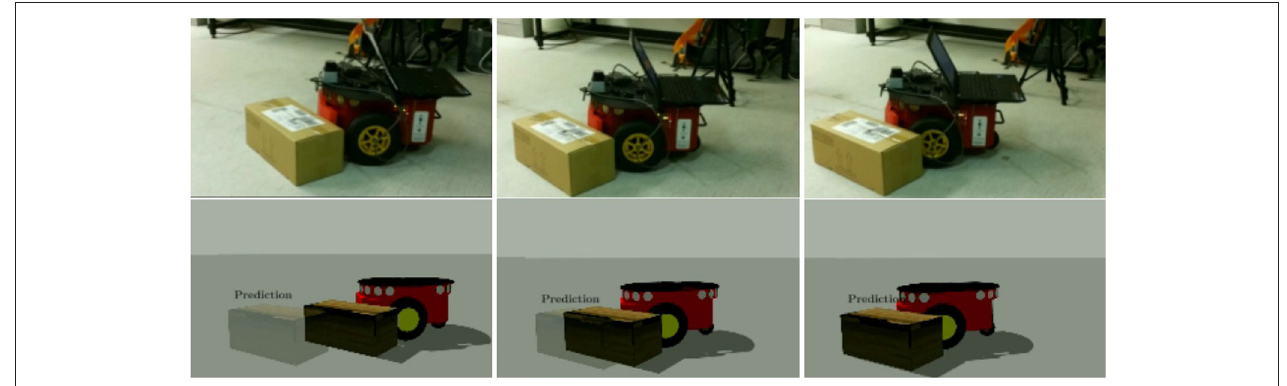
FIGURE 1 | Our test scenario. A Pioneer 3DX equipped with a 3D printed bumper pushing a novel object. The robot is capable of predicting the effects of the push even if the carton box is not present in the training data. (Left) The real robot executing the action. (Right) The action is repeated in simulation where our prediction for the pose of the object at the end of the pushing action is